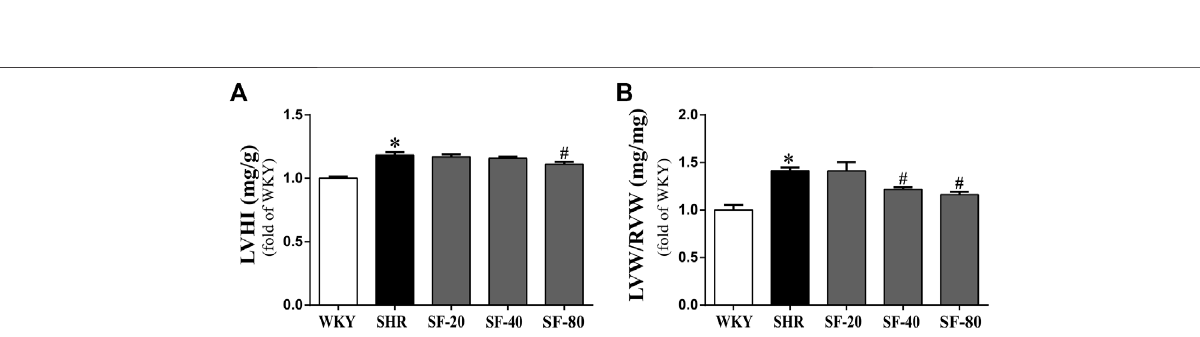
Frontiers in Pharmacology |